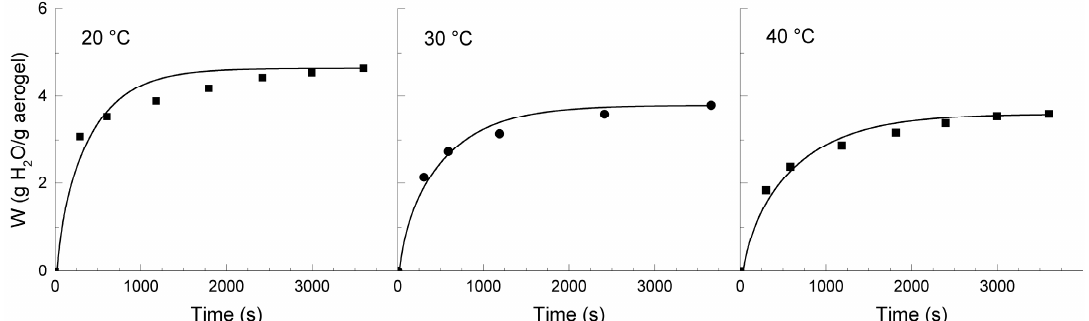
Figure 6. Swelling curves of the CsE aerogels in water at different temperatures (20, 30, and 40 °C). Experimental data (points) and adjustment (lines) with Equation (2) are included.